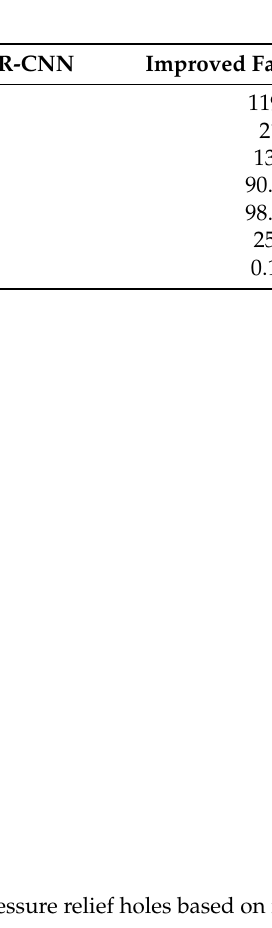
Table 7. Relief hole target recognition results based on YOLO v3, YOLO v4, and YOLO